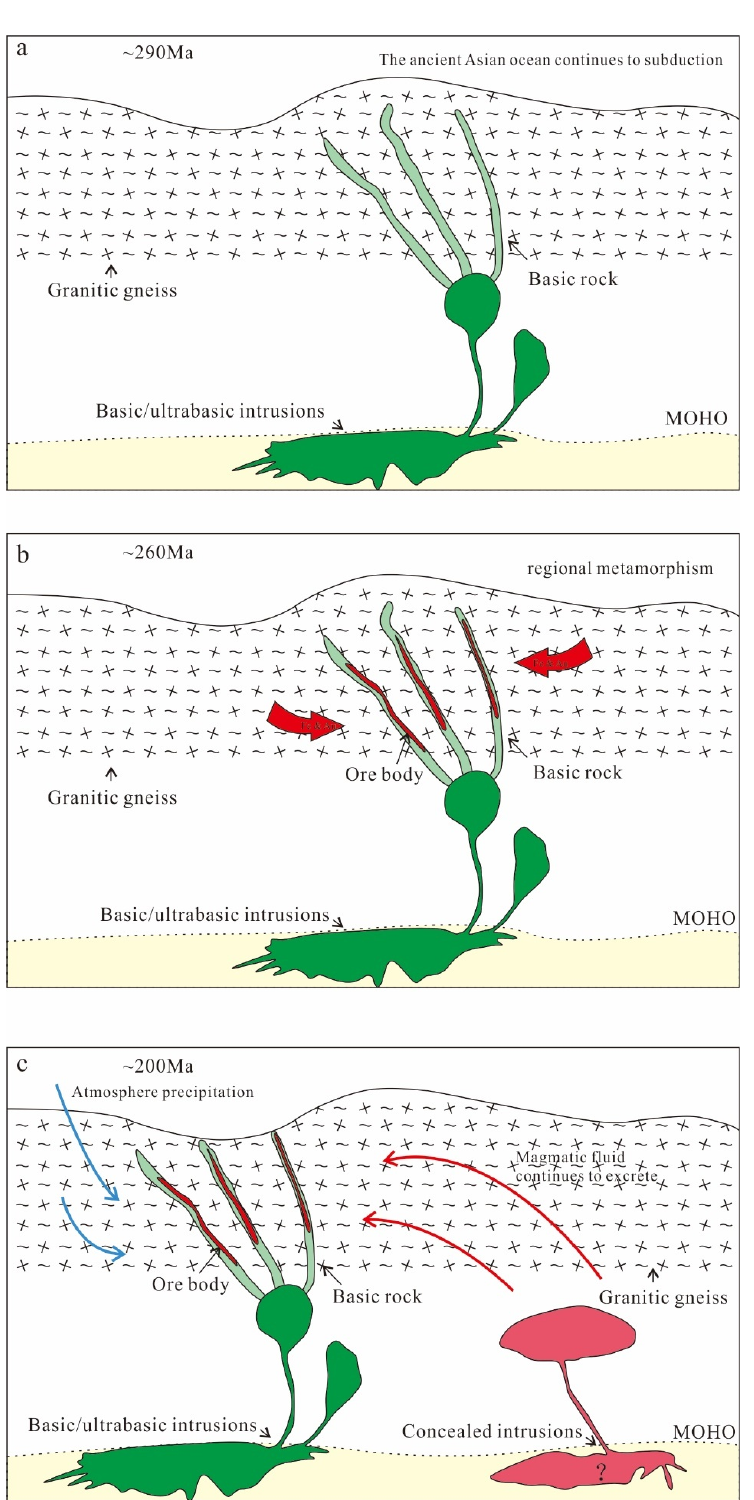
Figure 13. Metallogenic model diagram of the Weizigou deposit. ( a) intermediate-basic magma ascended into the shallow crust and intruded into the granitic gneiss; ( b ) metamorphic fluid extracted Fe and Au and generat orebodies; ( c ) magmatic-hydrothermal mineralization in the Early Jurassic. MOHO—Mohorovicic Discontinuity.